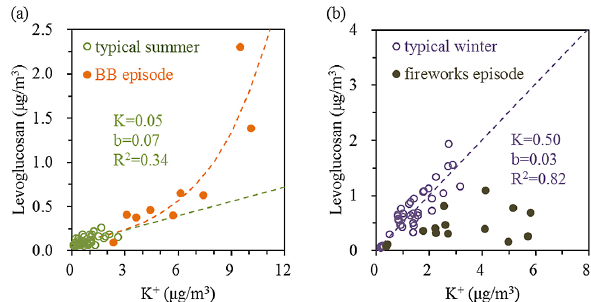
Fig. 3. The dependence of levoglucosan on K + during summer (a) and winter (b) in Beijing. Linear regression results for the typical summer and typical winter period are shown in (a) and (b) , respec- tively. K indicates the regression slope, while b is the intercept. In (a) , an exponential fit ( R 2 = 0 . 79) was shown for the comparison of levoglucosan and K + during the BB episode, whereas the corre- lation between levoglucosan and K + tended to be linear if remov- ing the two points with extremely high levoglucosan concentrations (slope = 0.09 ± 0.02, intercept = 0.03 ± 0.12, R 2 = 0 .